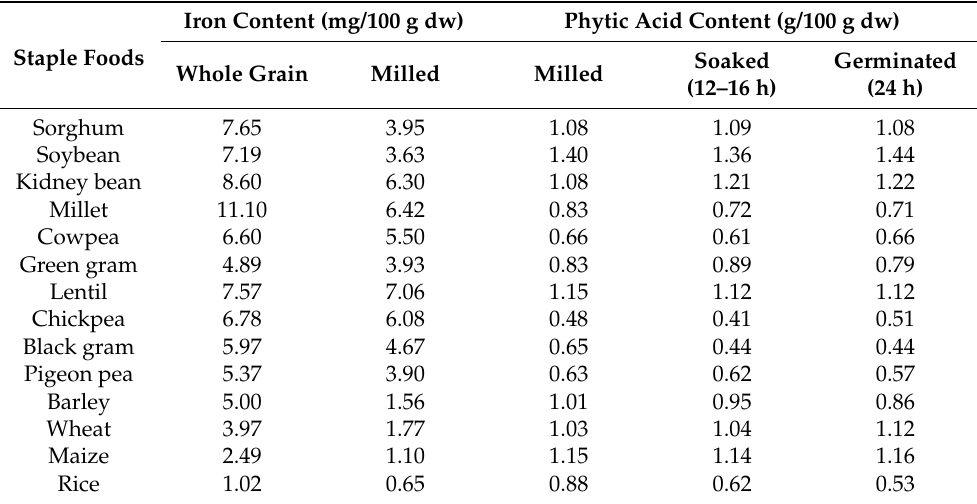
Table 3. Typical iron and phytic acid content in commonly consumed Indian staple